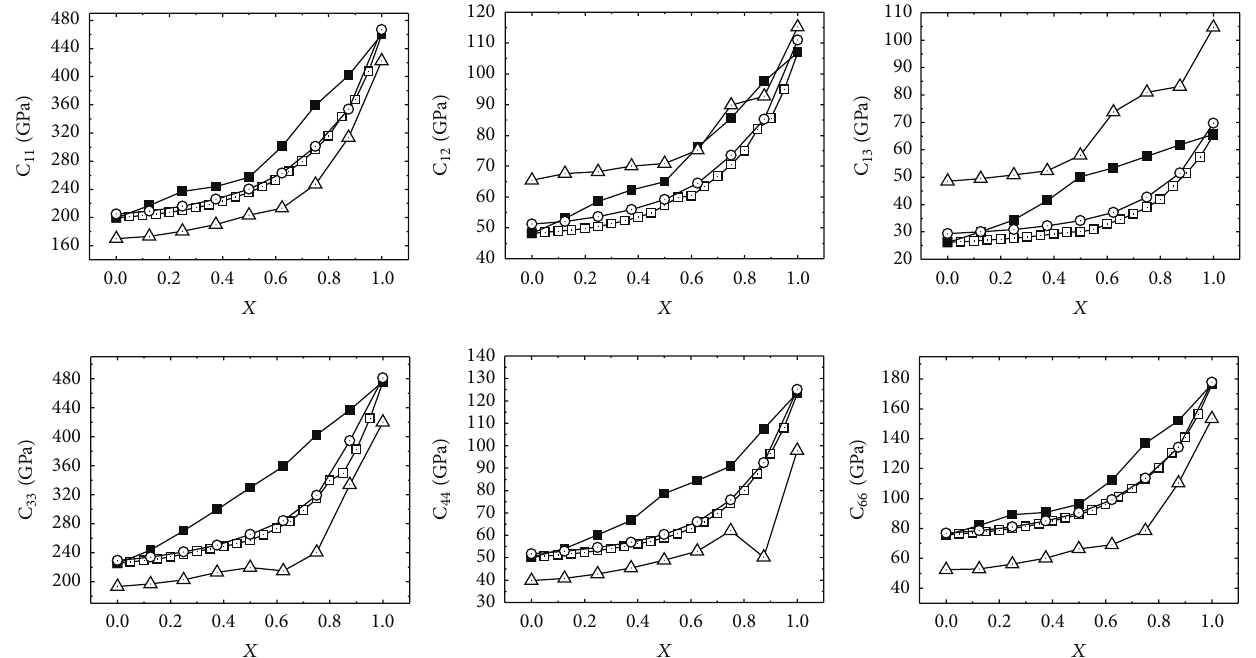
Figure 3: Composition dependence of the elastic constants in the wurtzite (WZ) structure. Each graph presents one constant calculated using all the methods. Filled points represent the supercell (SC) alloy simulation while empty points represent the alchemical mixing (AM). Squares: finite difference method, circles: clamped case of DFPT, and triangles: relaxed case of DFPT.